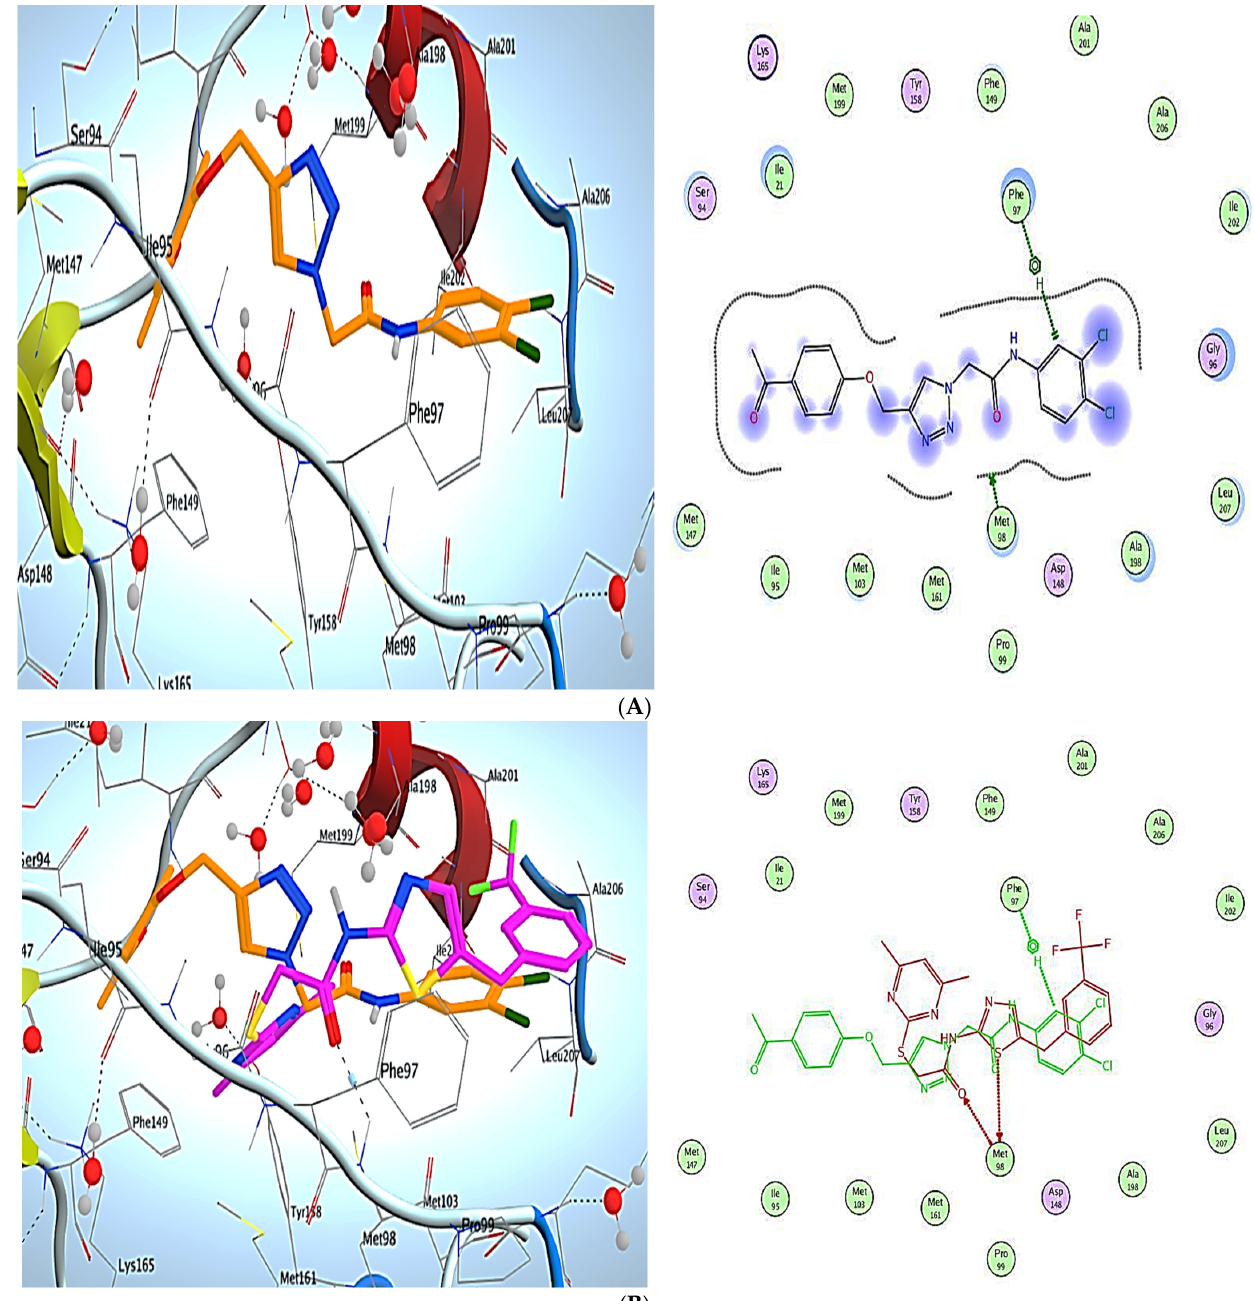
Figure 8. ( A ): Docking and binding pattern of compound 11 into InhA active site (PDB ID: 4UVD) in 2D (right panel) and 3D (left panel). ( B ): An overlay of the docked pose of compound 11 (brown) with the co-crystallized ligand (purple) into InhA active site in 2D (right panel) and 3D (left panel).